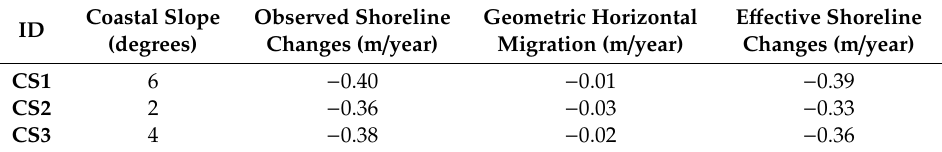
Table 1. E ff ective shoreline rate changes between 1999 and 2020 in the Gulf of Taranto, corrected with geometric horizontal migration rates.